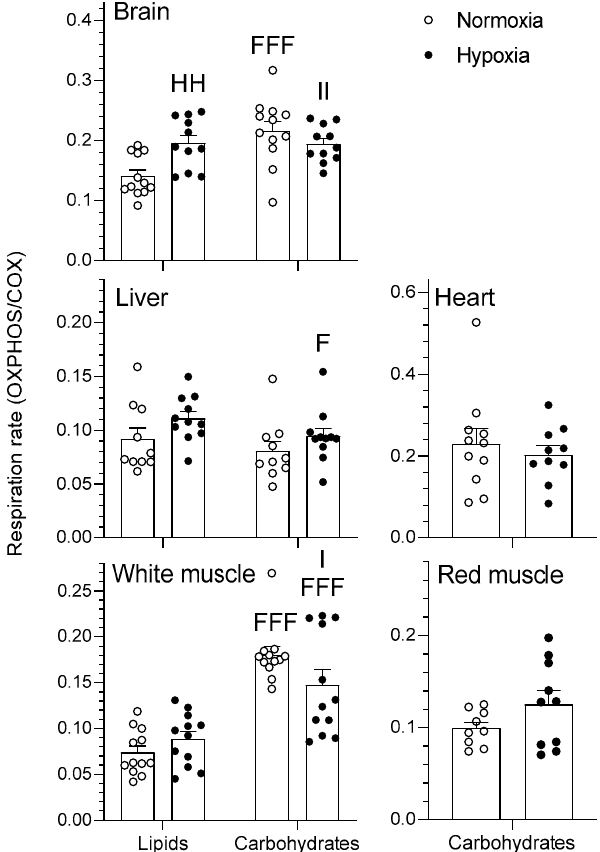
Figure 2. Mitochondrial oxidative fuel preference during oxidative phosphorylation (OXPHOS) respiration (pmol O 2 sec − 1 mg − 1 ) normalized to COX respiration in the tissues of normoxic controls ( N = 12) and hypoxia-acclimated goldfish ( N = 11). OXPHOS represents mitochondrial respiration following the addition of saturating concentrations of ADP in the presence of pyruvate/malate for the carbohydrate protocol and palmitoylcarnitine/malate for the lipid protocol. Values are means ± s.e.m. Dots represent individual data points. Differences between fuels are indicated as F ( p < 0.05) and FFF ( p < 0.001). Difference between oxygen levels is indicated as HH ( p < 0.01). Significant interactions between type of fuel and oxygen are indicated as I ( p < 0.05) and II ( p < 0.01).